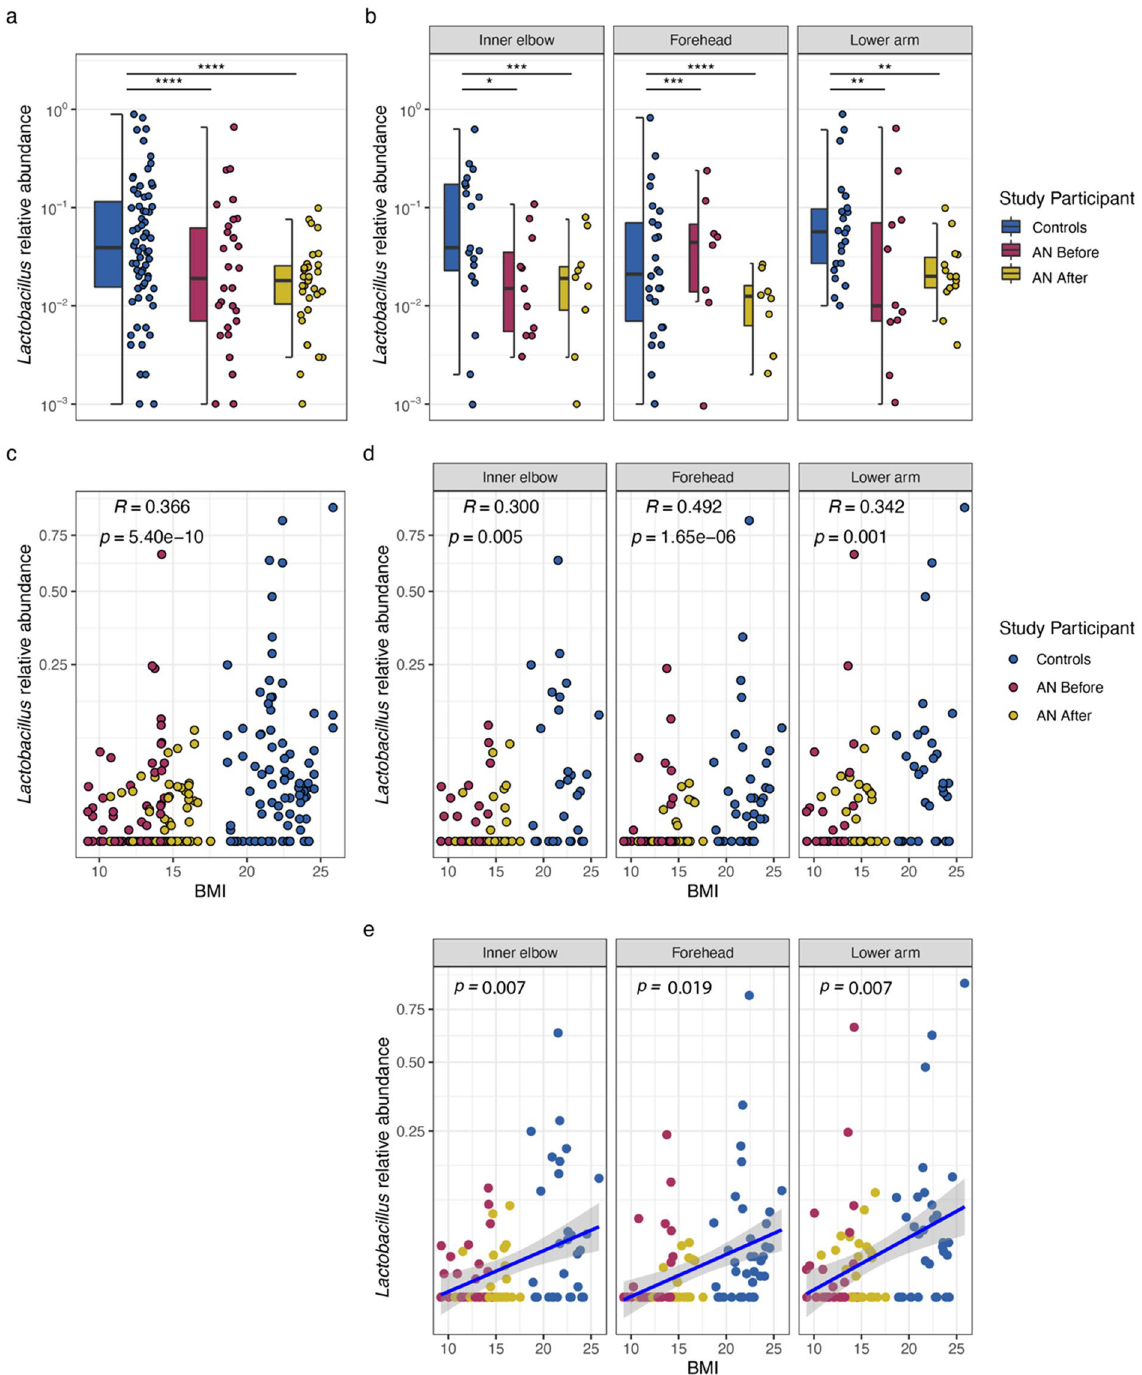
Figure 6. Box plots of relative abundances, Spearman correlations, and single linear regressions for Lactobacillus , an indicator genus. ( a ) Box plot of Lactobacillus relative abundances for healthy-weight controls and patients with AN by weight gain group (before and after) and, ( b ) faceted by sampling location. Wilcoxon test (see “Methods” section); p -values: *< 0.05; **< 0.01; ***< 0.001. Line indicates the median concentration; box shows the interquartile range (IQR), and the whiskers are 1.5 × IQR. ( c ) Spearman correlation between indicator Lactobacillus and BMI, and at ( d ) individual sampling locations ( e ) Single linear regression model between BMI and relative abundance of Lactobacillus at the inner elbow (R 2 adj = 0.085; p = 0.007) , the forehead (R 2 adj = 0.048; p = 0.019), and at the lower arm (R 2 adj = 0.076; p = 0.007). r(s) = spearman’s Rho. AN anorexia nervosa, BMI body mass index. Blue represents healthy-weight controls, red represents patients with AN before weight gain, and gold represents patients with AN after weight gain. p -values were adjusted for multiple testing according to Benjamini and Hochberg 94